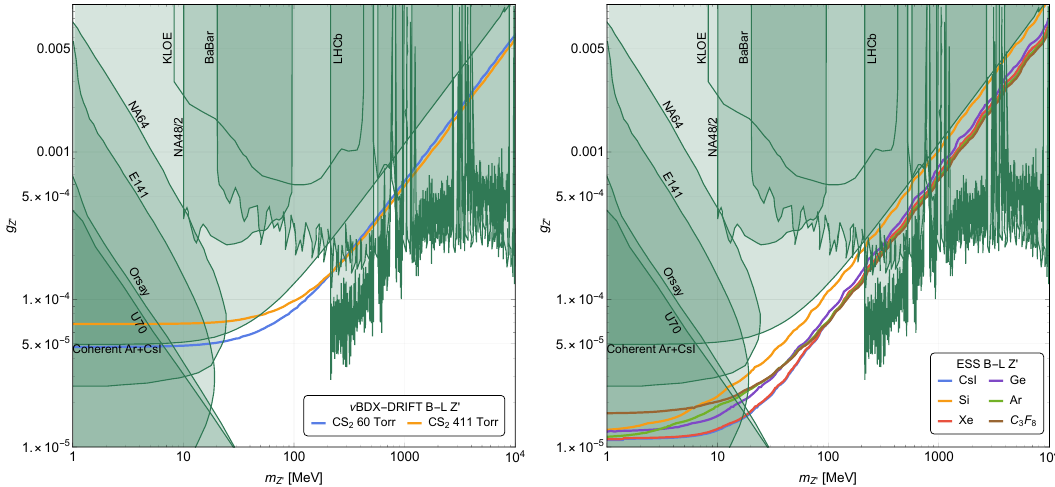
Figure 3. Future sensitivity at 90% C.L. in the m Z 0 − g Z 0 plane for the B − L model for the ν BDX- DRIFT detector (left) exploiting CS 2 at two different pressures, and the various detectors described in the text at the ESS (right). The dark green regions are excluded at 90% C.L. by NA64